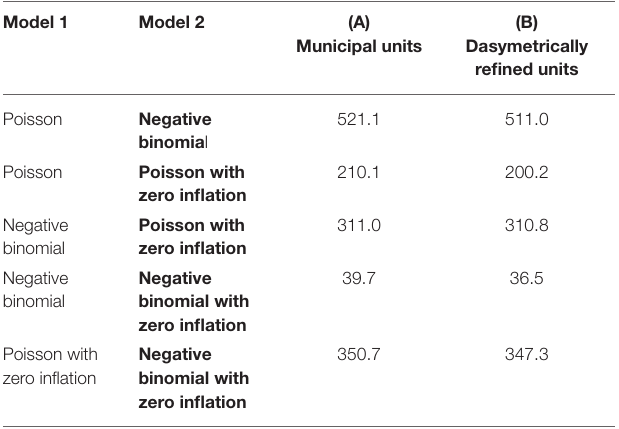
TABLE 2 | Pairwise likelihood-ratio tests comparing the different regression models based on the two enumeration types — (A) municipal units and (B) dasymetrically refined units. The P value of the tests is consistently < 0.05. The best model is highlighted in